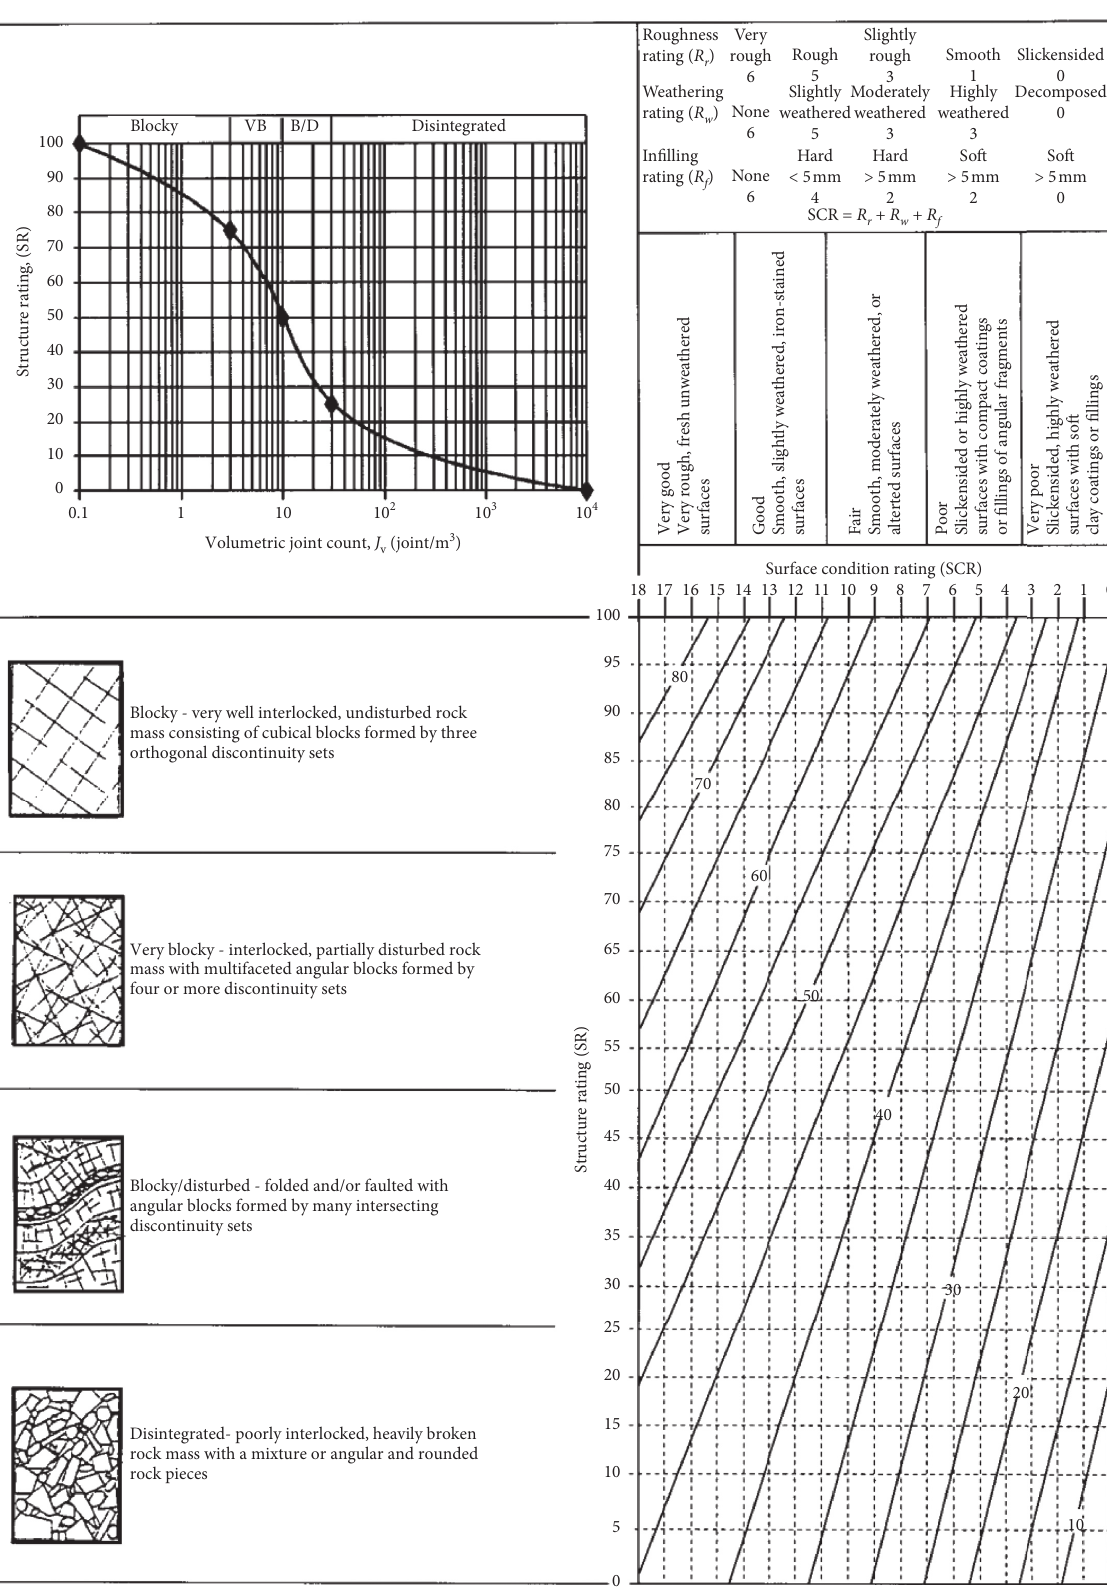
Figure 5: Quantification of the GSI chart